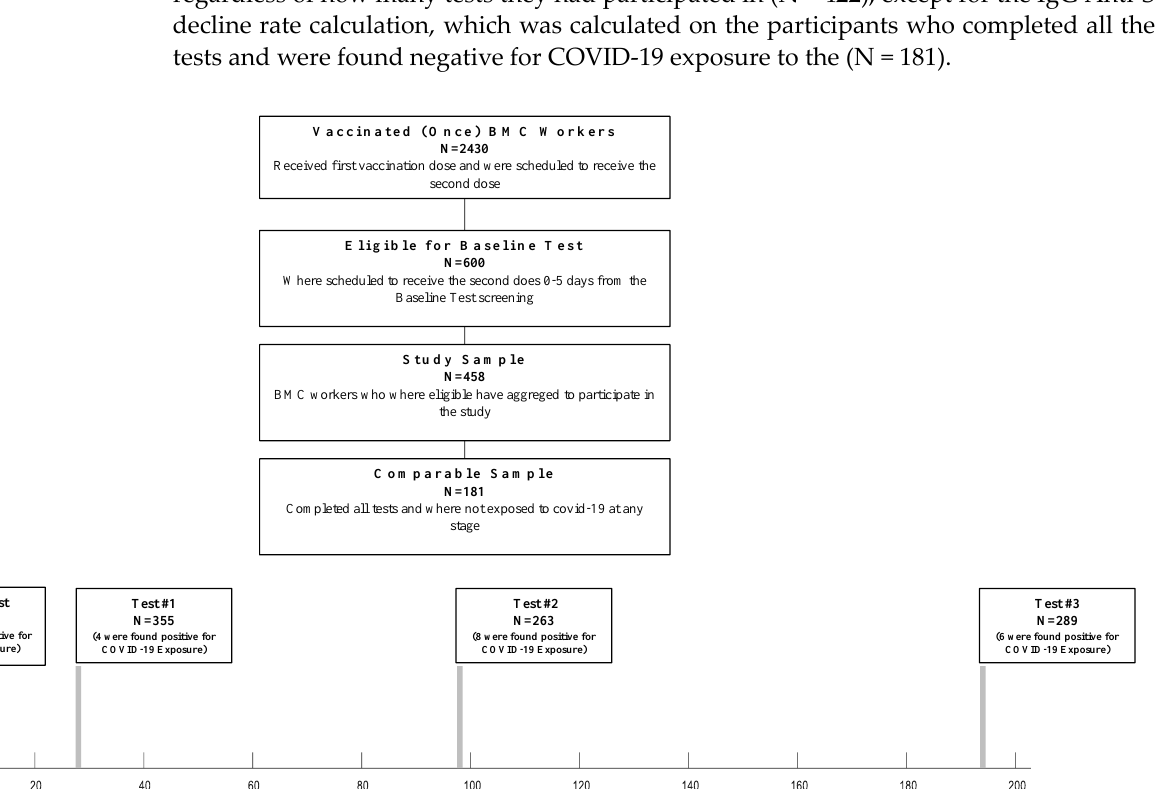
Baseline Test N=452